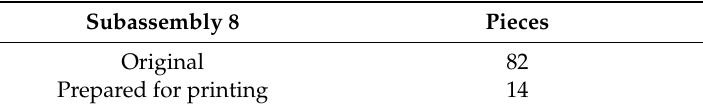
Table 3. Simplification of pieces of Subassembly 8.